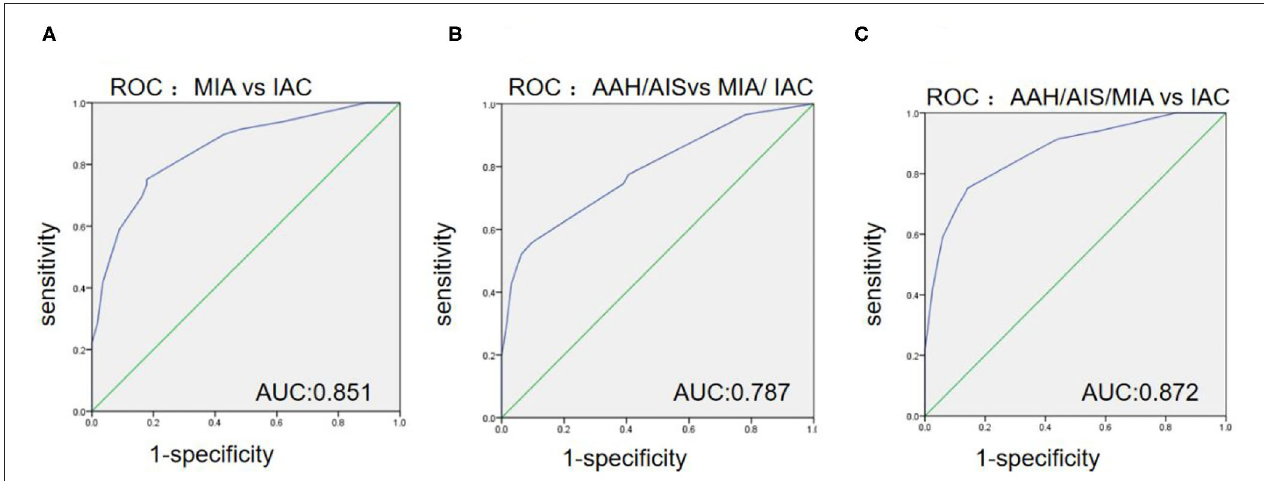
FIGURE 3 | The ROC curves among the different paired groups of pathological subtypes. (A) Minimally invasive adenocarcinoma (MIA) vs. invasive adenocarcinoma (IAC); (B) Atypical adenomatous hyperplasia (AAH)/adenocarcinoma in situ (AIS) vs. MIA/IAC; (C) AAH/AIS/MIA vs. IAC.